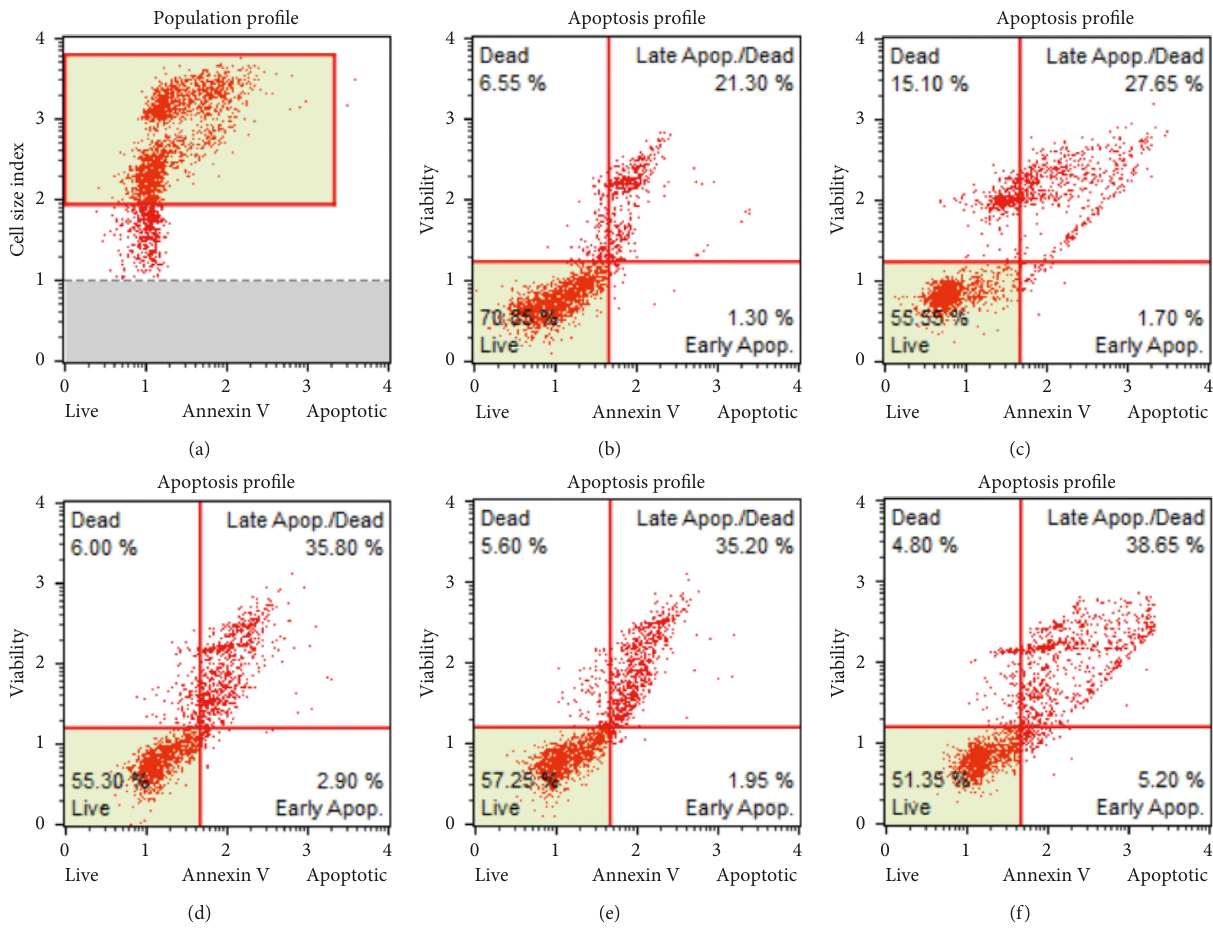
Figure 3: Apoptotic profile after treatment with various compounds in HCT116cells was determined as % live,% early, and late apoptosis and % dead cells by MUSE cell analyzer: (a) normal control; (b) normal control; (c) SAHA (5 µ M); (d) quercetin (100 µ M); (e) QMJ-2 (100 µ M); (f) QMJ-5 (50 µ